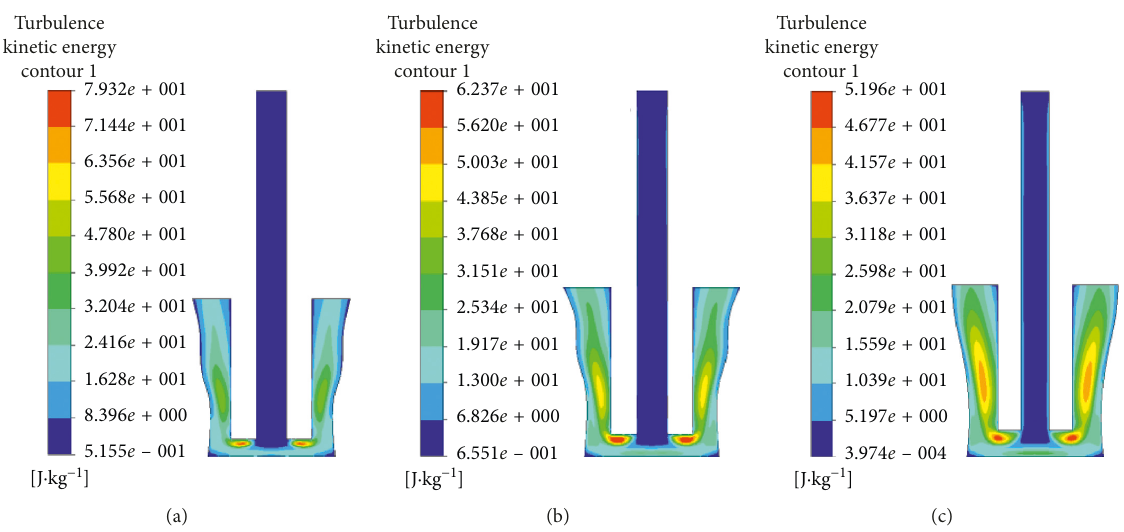
Figure 16: Electrolyte flow eddy distribution under different applied voltages. (a) U � 7V, ξ � 9% (wt.%). (b) U � 9V, ξ � 9% (wt.%). (c) U � 13 V, ξ � 9%